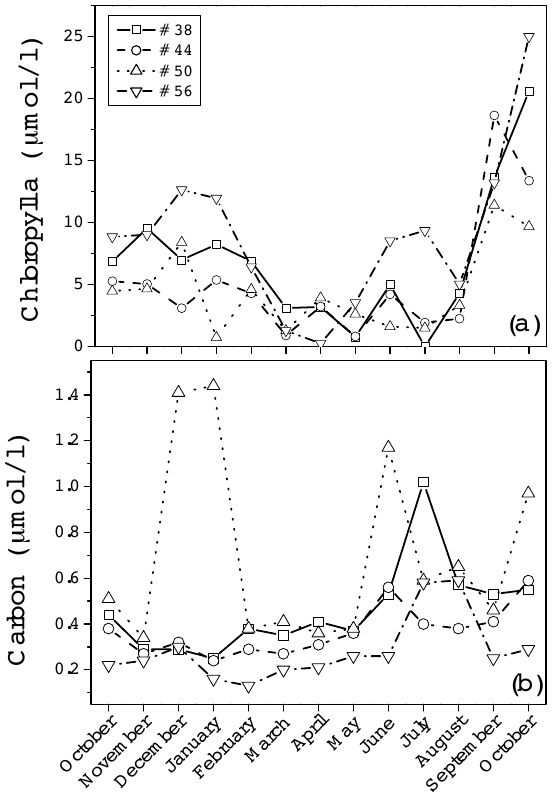
F IG . 4. – Time distribution of Chlorophyll a (a), and Carbon (b) con- centrations for the four analysed stations. Legend is shown in (a).